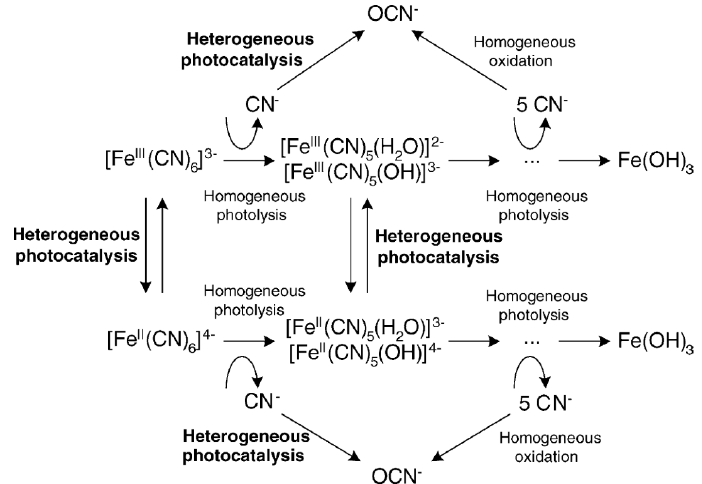
Figure 1. Mechanism of the heterogeneous photocatalytic degradation of Hexacyanoferrate [25]. Reprinted from Applied Catalysis B: Environmental, 55, Rafael van Grieken *, José Aguado, María-